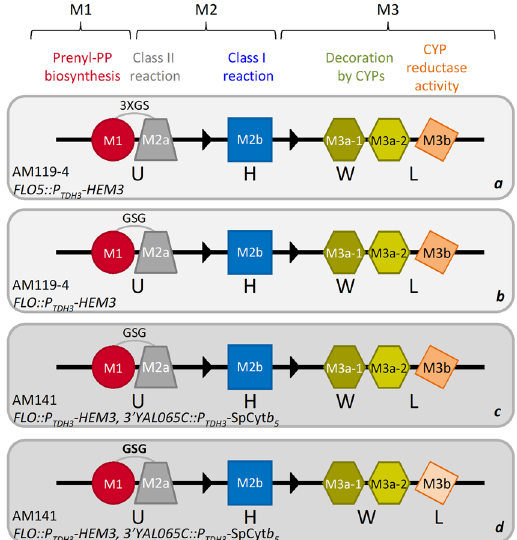
Figure 2. Depiction of the engineered yeast platform for production of carnosic acid-related diterpenes. The modular yeast platform previously developed in AM119-4 strain (panel a , light grey background; ref. 20) was optimized for carnosic acid production in three steps, including engineering of a shorter linker (GSG) between the M1 and M2a parts (panel b ), chromosomal integration of SpCyt b 5 in strain AM141 (dark grey background) (panel c ), and modulation of CPR expression by switching from the strong inducible promoter P GAL1 (dark orange) to the weaker constitutive P TPI1 promoter (light orange) (panel d